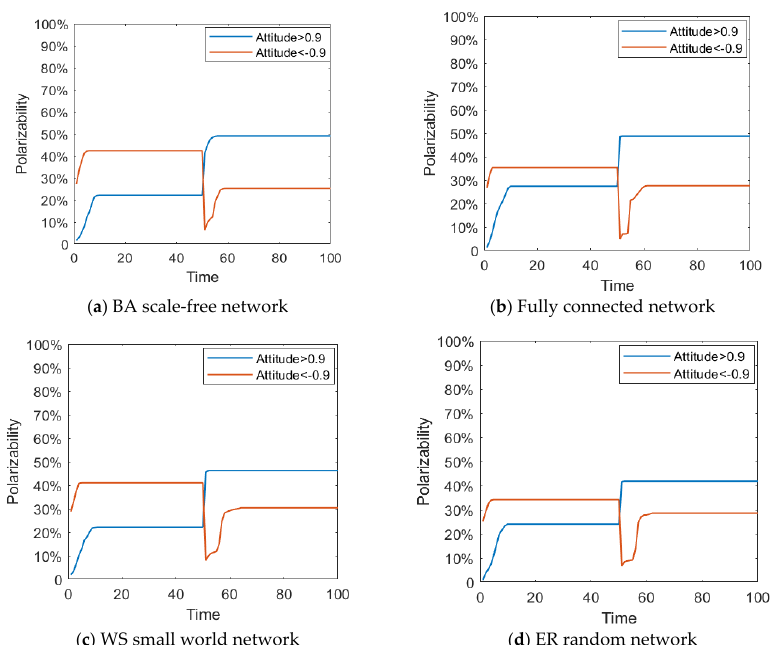
network; ( b )Fully connected network; ( c ) WS small world network; ( d ) ER random network.